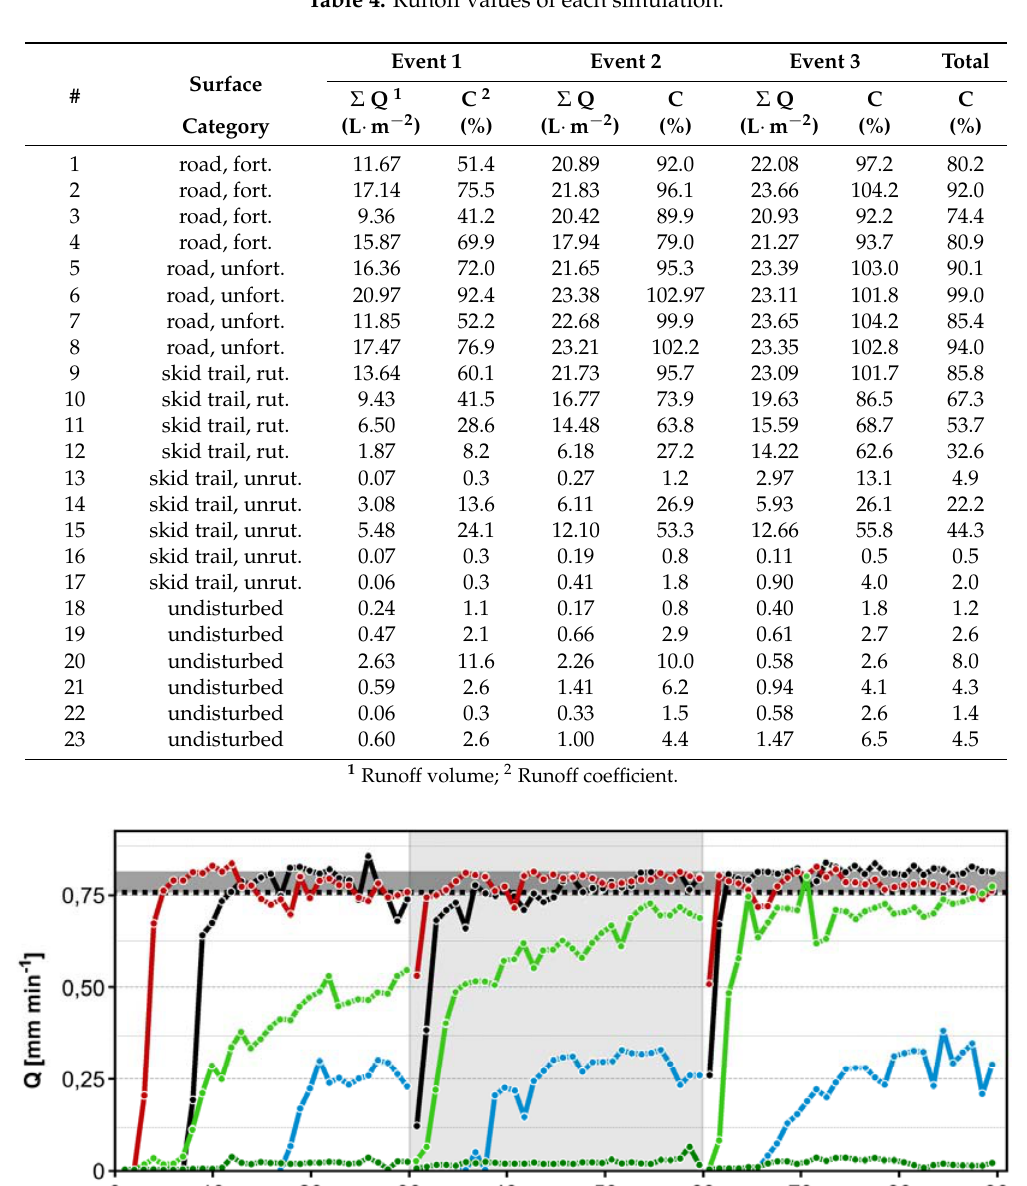
Table 4. Runoff values of each simulation.